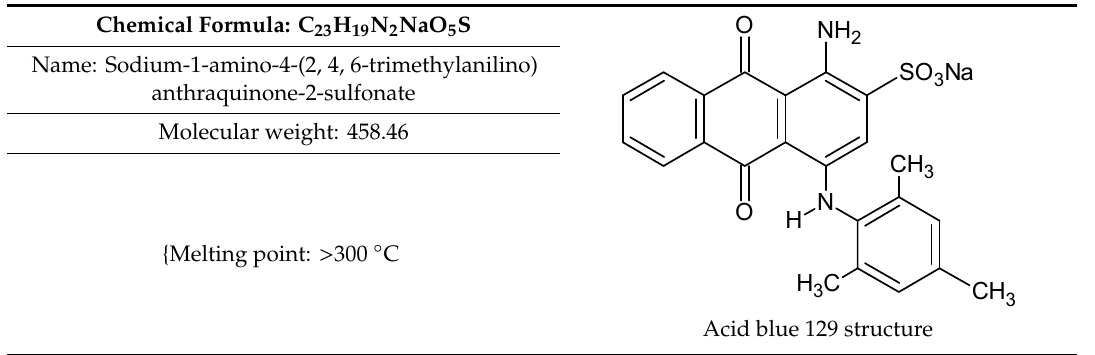
Table 1. Acid blue 129 (AB129) properties and structure